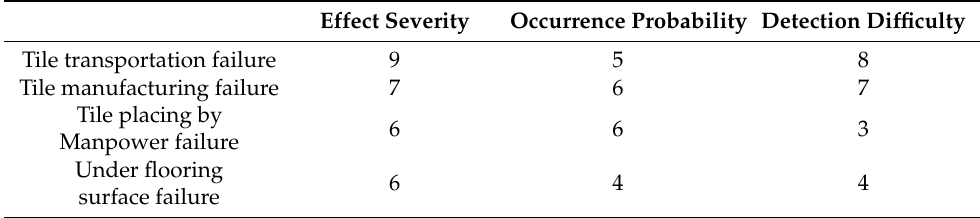
Table 9. The decision matrix for identifying the most critical failure mode.